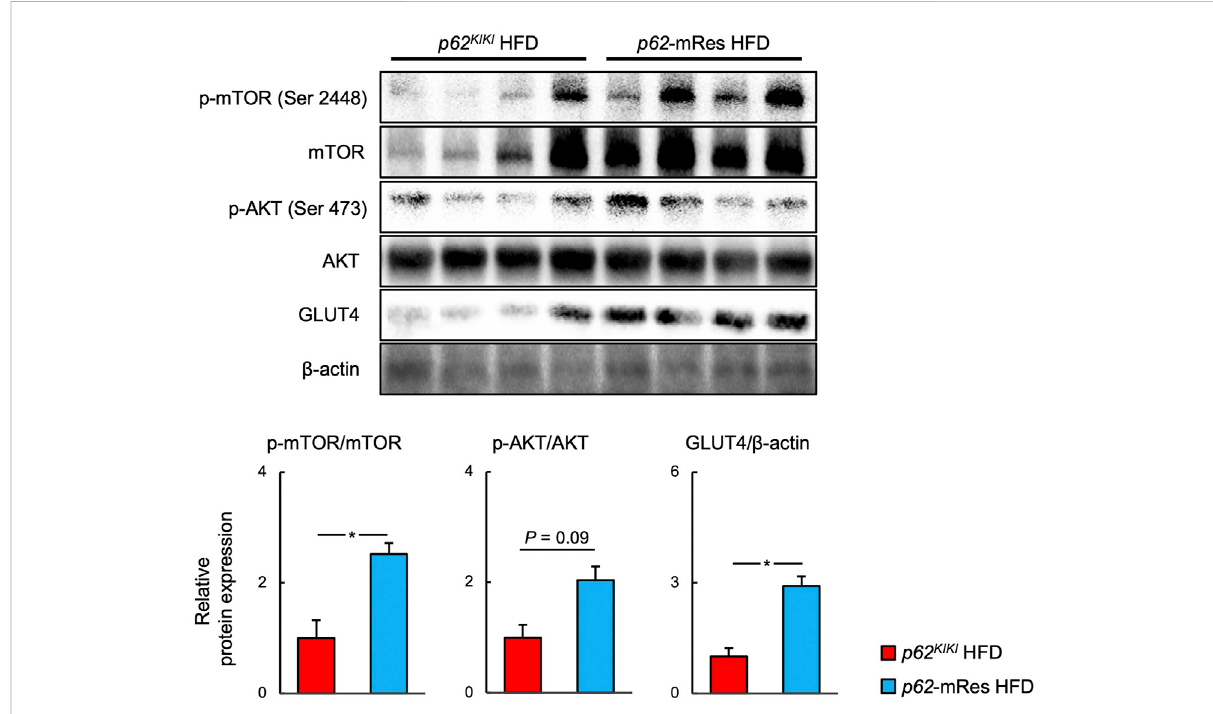
FIGURE 6 p62 in muscle activates mTOR and increases the expression of GLUT 4. Representative immunoblots of quadriceps muscle for the phosphorylation of mTOR (p-mTOR, Ser 2,448), total mTOR, phosphorylation of AKT (p-AKT, Ser 473), total AKT, GLUT4, and β -actin in p62 KIKI and p62 -mRes mice fed an HFD. Quanti fi cation of protein levels. p-mTOR and p-AKT levels were normalized to those of total mTOR or total AKT. GLUT4 levels were normalized to those of β -actin ( n = 5 – 6/group). Values are mean ± SEM. * p < 0.05 (unpaired t